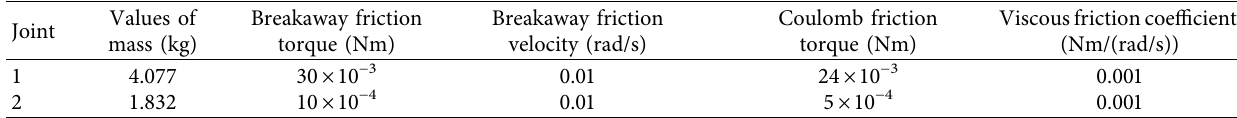
Table 3: Parameters of revolute joint in